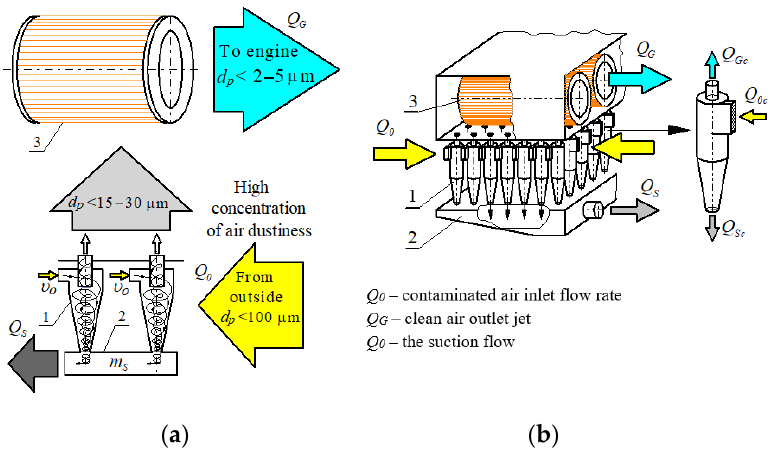
Figure 2. Two-stage (multicyclone, filter bed) filtration system for the inlet air of an off-road vehicle engine: ( a ) essence of the two-stage filtration system; ( b ) functional diagram of the two-stage filter, 1 — multicyclone (first filtration stage), 2 — dust settler and 3 — paper filter bed (second filtration 1—multicyclone (first filtration stage), 2—dust settler and 3—paper filter bed (second filtration stage).